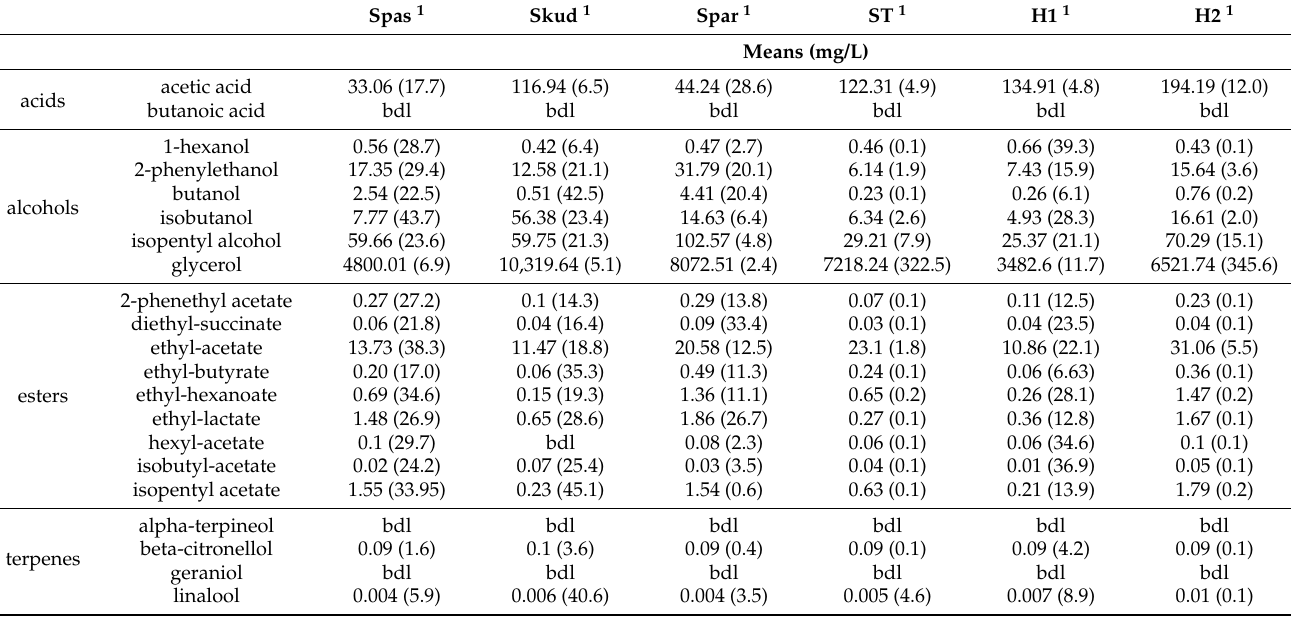
Table 4. Average concentrations of the volatile compounds and glycerol using “K é knyel˝u” grape juice for fermentation. The RSD (%) values are